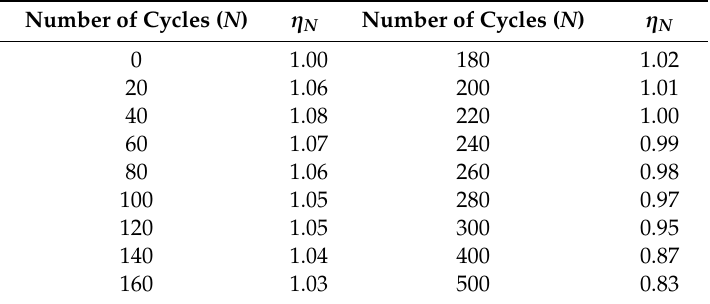
Table 1. Cycle number compensation coe ffi cient η N